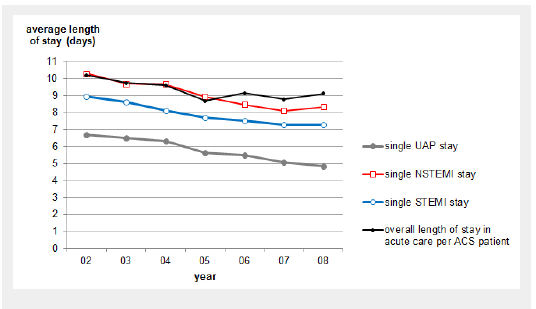
Average length of stay in acute care by single stay and by patient (2002–2008). Own calculation on the basis of MedStat [11]. Average length of stay per patient is higher than average length of single stays as many patients have multiple stays in the course of their ACS treatment (e.g. when a patient is transferred from one hospital to another for specialised care).